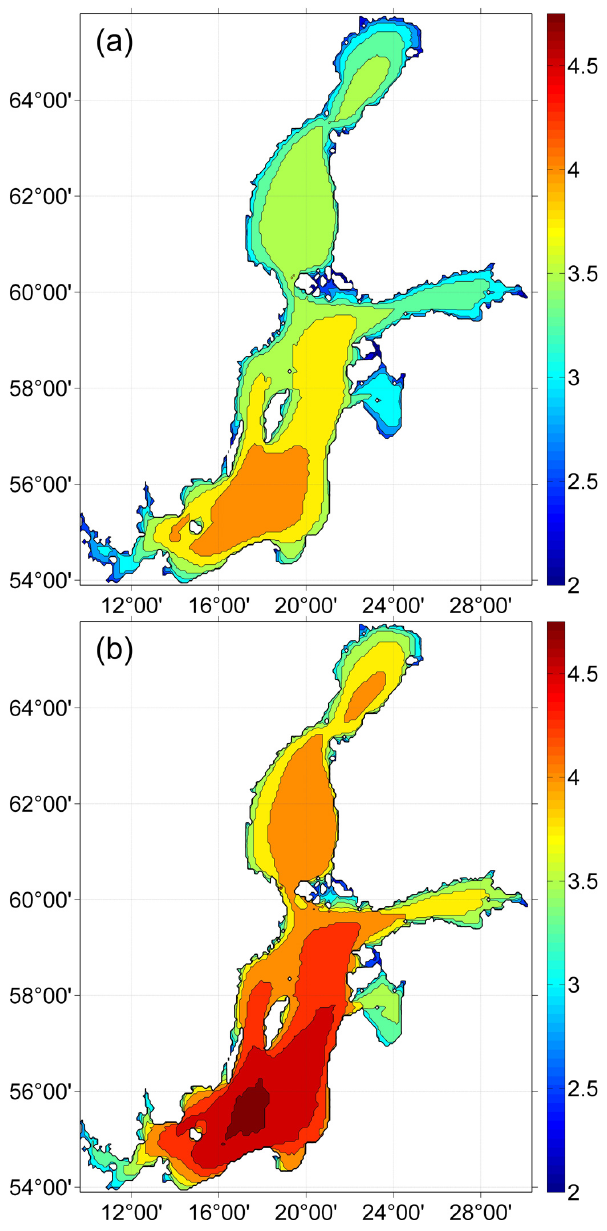
Fig. 3. Numerically simulated mean (a) and peak (b) periods (s; isolines plotted after each 0.5s) in the Baltic Sea in 1970–2007.